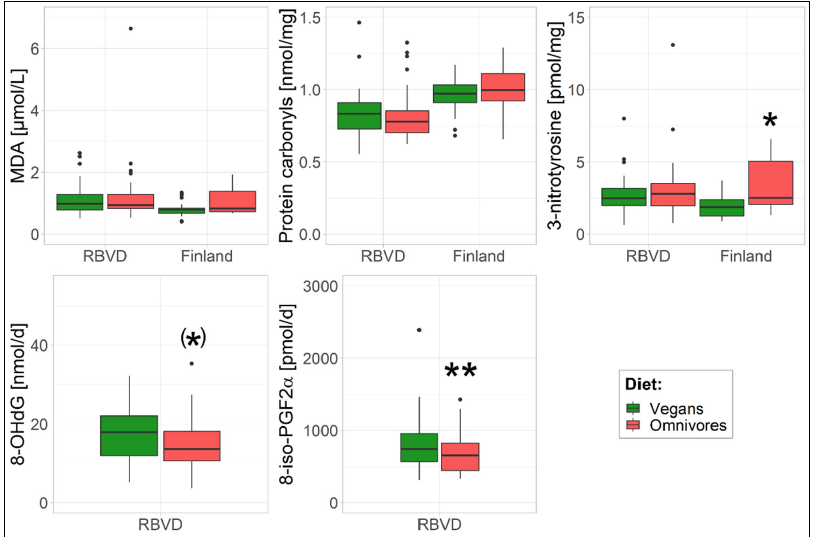
Figure 1. Boxplots of oxidative biomarkers in the three study populations. Dots represent extreme values. ( * ) p with trend, * p < 0.05; ** p < 0.01; p -values of model 3 in Table 2 are reported. Table 2. Biomarkers of oxidative damage according to vegan or omnivorous diet in the RBVD and the Finnish